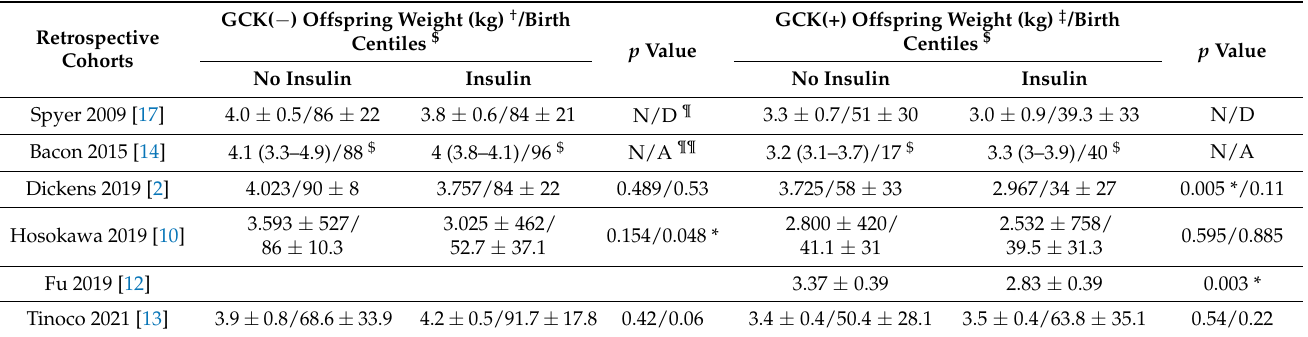
Table 2. Birthweight and Birth Centiles in Treated Versus Untreated Pregnancies.